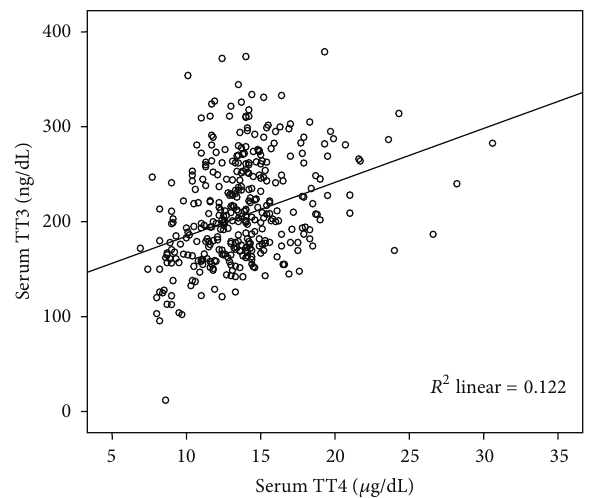
Figure2:ScatterplotofcorrelationbetweenTT4andTT3( 𝑟 = 0.35 , 𝑃 < 0.001 ).